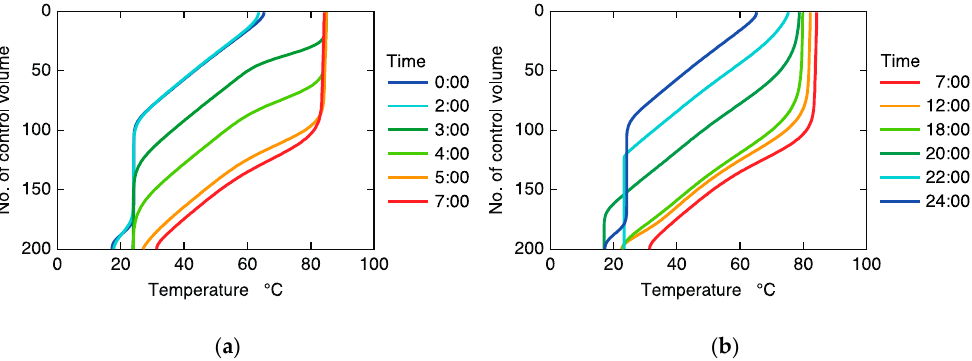
Figure 8. Changes in temperature distribution in storage tank for system M: ( a ) Charging mode; ( b ) Tapping mode.